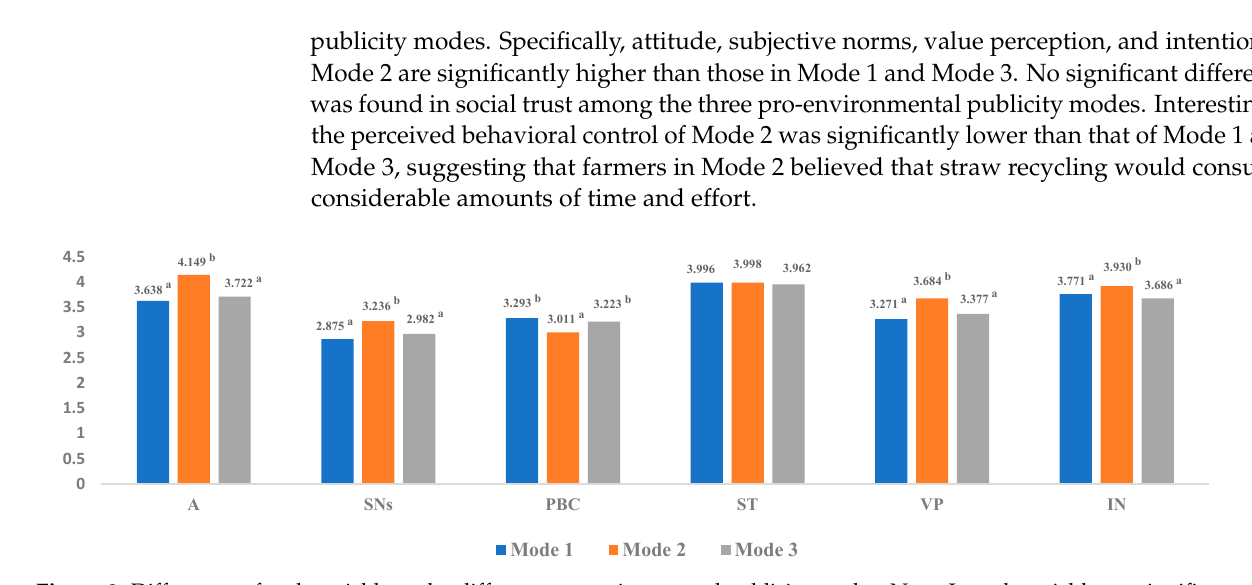
Figure 3. Differences of each variable under different pro-environmental publicity modes. Note: In each variable, no significant difference is found between the two groups of values with the same superscript, the two groups with different superscripts have significant differences, and the group of superscript b is larger than that of superscript a .